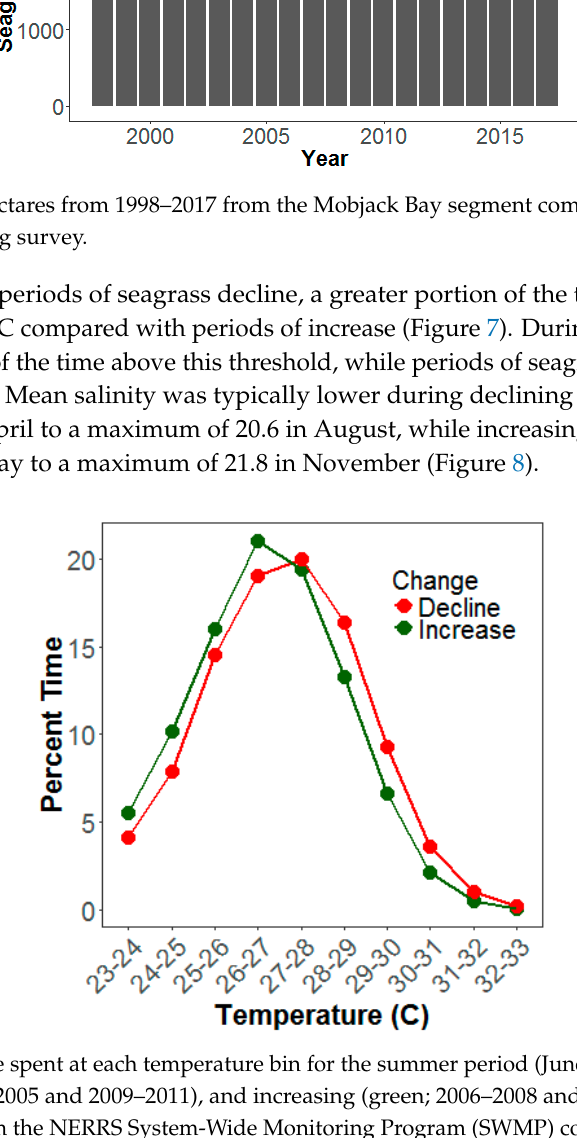
Figure 6. Seagrass hectares from 1998–2017 from the Mobjack Bay segment compiled from the VIMS annual aerial mapping survey.